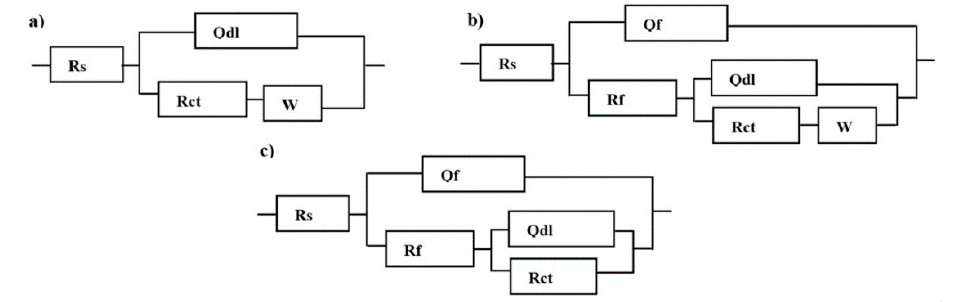
Figure 2. Nyquist ( a ) and Bode ( b ) plots for the Cu5Zn5Al1Sn alloy in 3.5 wt.% NaCl with and without different concentrations of cysteine (10 -5 to 10 -2 ) (scattered: experimental data; lines: fitting data).